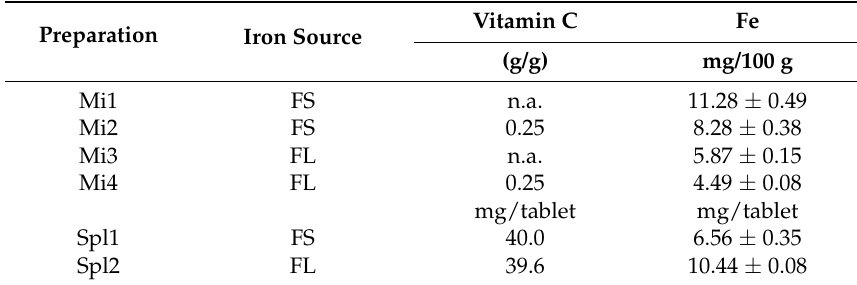
Table 2. Total iron and vitamin C content in preparations (Spl1 and Spl2—dietary supplements; Mi1—Mi4 fortificants of encapsulated iron) containing ferrous sulphate (FS) or ferrous lactate (FL).